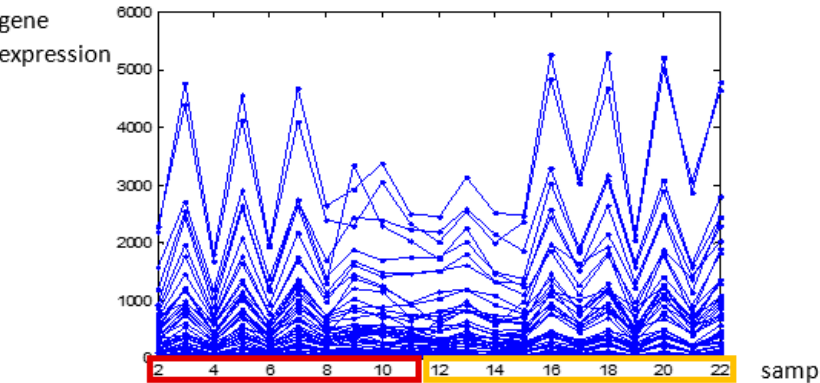
Figure 1. Profiles of the first 100 most differentially expressed genes of the two mice data sets. The first 10 samples (in red) are one mouse strain and the rest 11 (in yellow) are another strain.